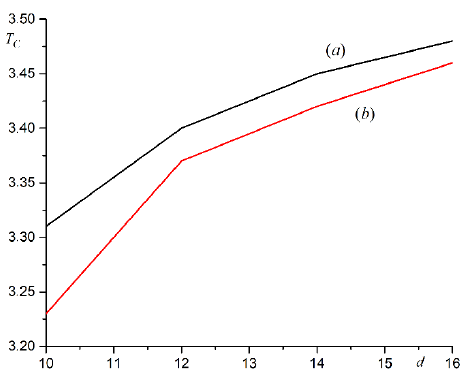
Figure 5. The dependence of the Curie temperature T C on the antidotes lattice period d for holes with a constant size: (a) square holes, (b) triangular holes. The red line is the Curie temperature for triangular holes and the black line is the Curie temperature for square holes.